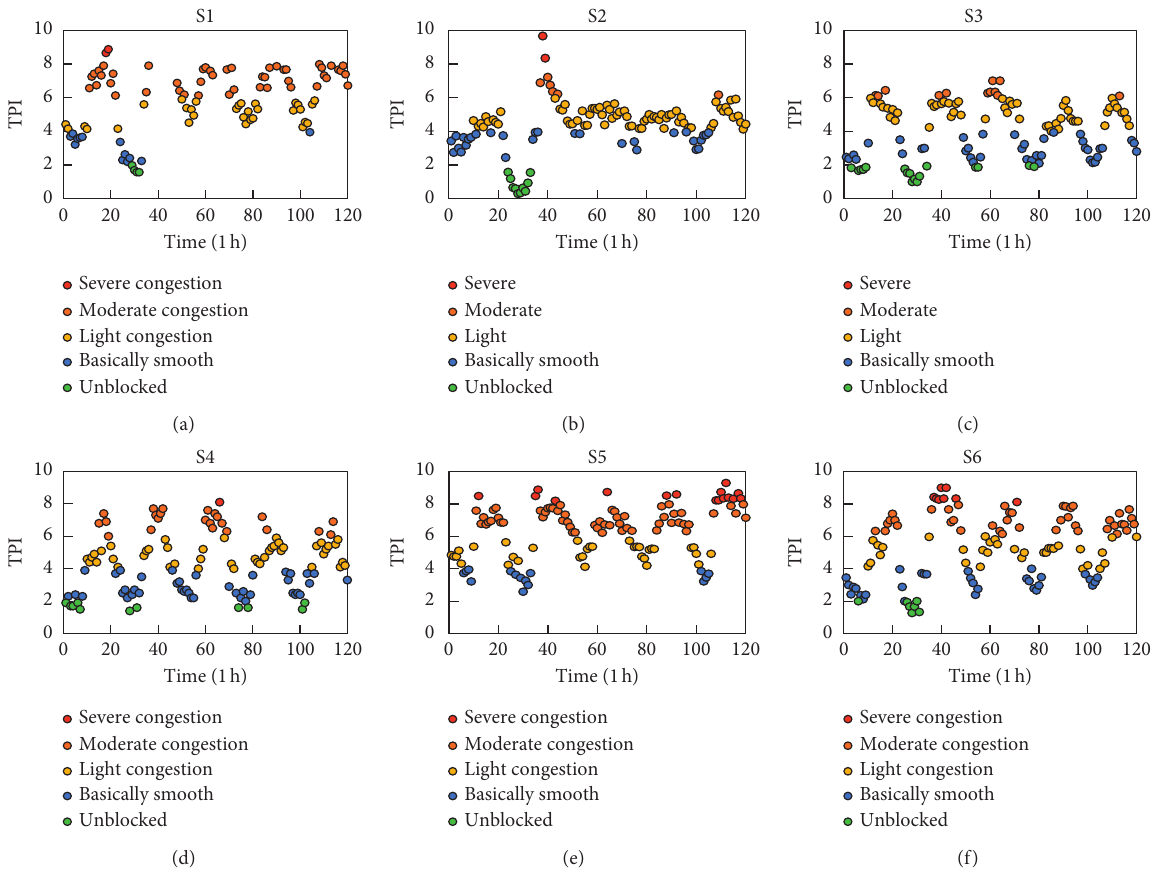
Figure 7: The TPI for the six road sections. (a) S1 (b) S2. (c) S3. (d) S4. (e) S5. (f) S6.